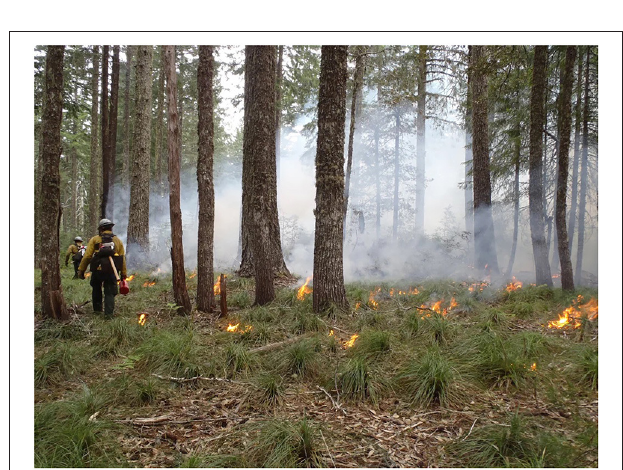
FIGURE 10 | In understory burning, one goal is to prevent harm to the larger trees, while suppressing growth of shade tolerant conifers that would crowd the stand, and create openings diverse species. In a cultural burn, goals may include enhancing culturally significant species and landscapes, and in some cases, influencing plant growth form for weaving or carving. The understory here contains a high density of beargrass ( Xerophyllum tenax ), a valued basketry resource requiring fire to promote desired leaf growth (Photo: Frank Lake, US Forest